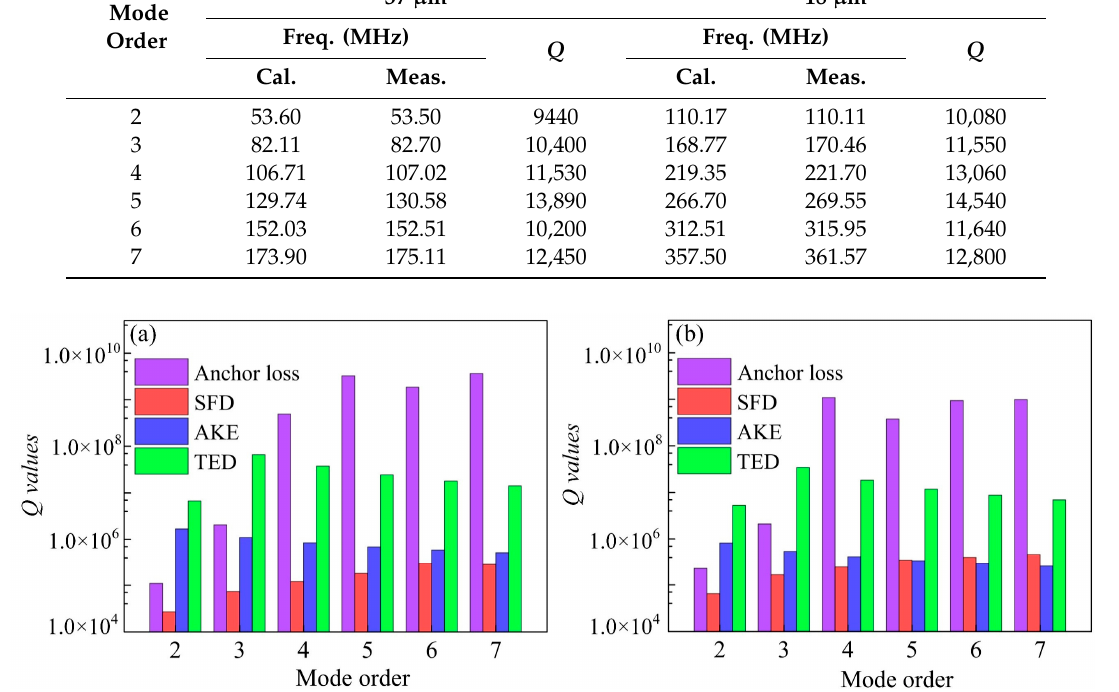
Figure 3. Comparison between the Q anchor and Q SFD values of each WGM for the 37 μ m ( a ) and 18 μ m- radius resonators ( b ).